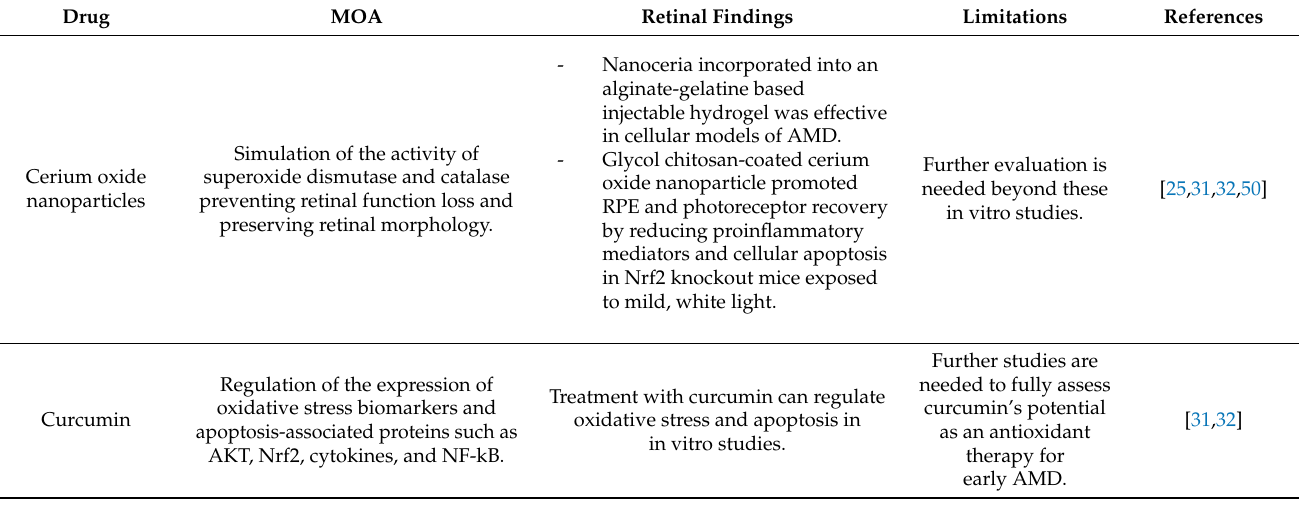
Table 3. In vitro and in vivo studies of natural drugs proposed for early AMD